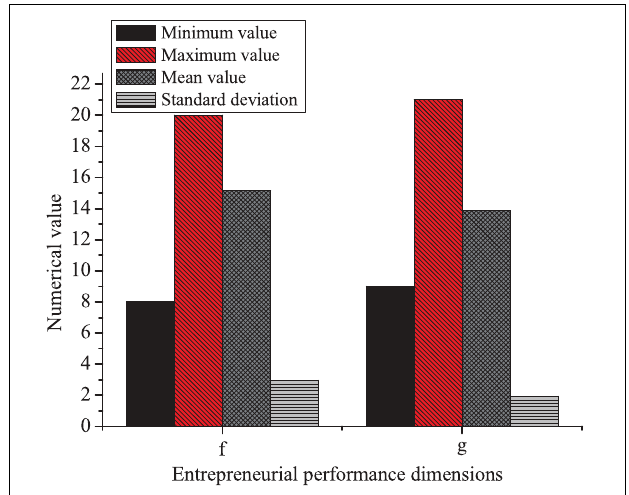
FIGURE 7 | Statistical results of the entrepreneurial performance scale (f: developmental, g: